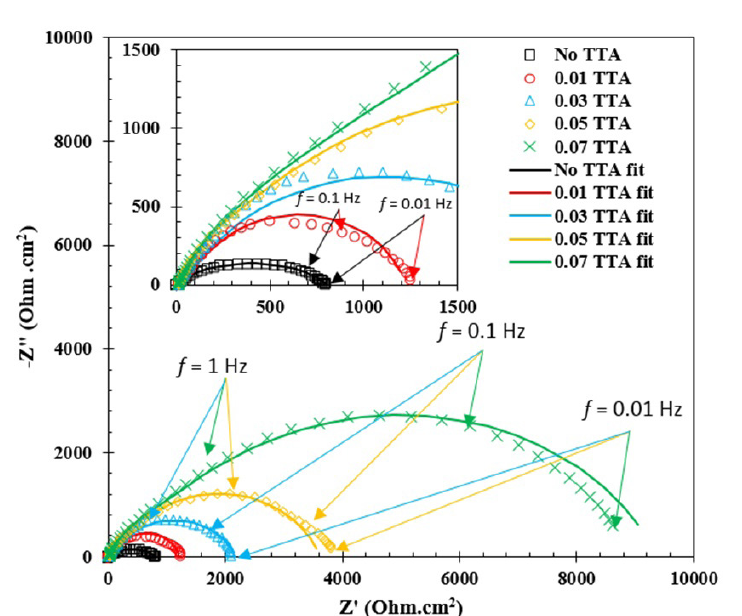
Figure 7. Nyquist diagrams for the corrosion of mild steel in 0.5 M HCl solution with various concentrations of TTA (0.01 to 0.07 M) at 293 K.